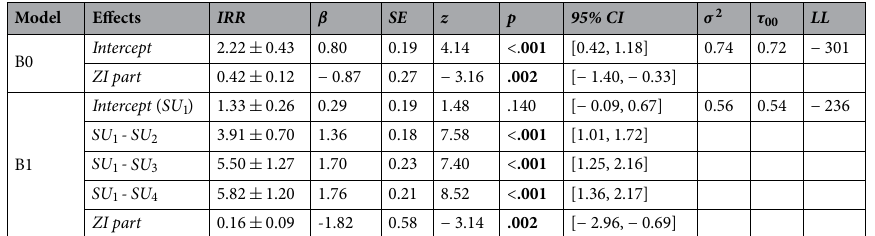
2 variance of level-1